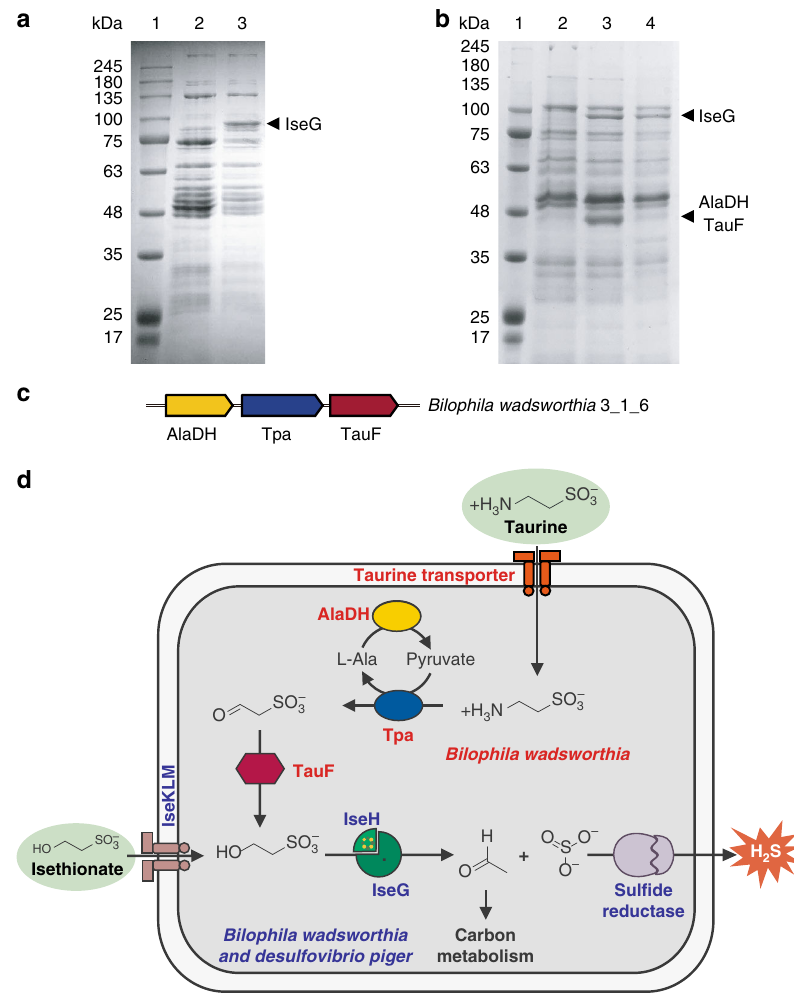
Fig. 4 C2 sulfonate induced IseG-dependent pathway in SSRB. a SDS-PAGE analysis of D. piger grown on lactate plus sulfate (lane 2) or isethionate (lane 3). The arrow indicates a ~95-kD band identi fi ed as IseG. b B. wadsworthia grown on pyruvate plus thiosulfate (lane 2), taurine (lane 3) or isethionate (lane 4). The arrows indicate a ~95-kD band identi fi ed as IseG, and a ~40-kD band containing both AlaDH and TauF. c Genome neighborhood of B. wadsworthia Tpa and AlaDH, showing the proximity to a gene in the ADH superfamily, found to be a NADH-dependent sulfoacetaldehyde reductase TauF. d Proposed pathways for dissimilation of isethionate and taurine in D. piger and B. wadsworthia . Source data are provided as Supplementary Data 2 –